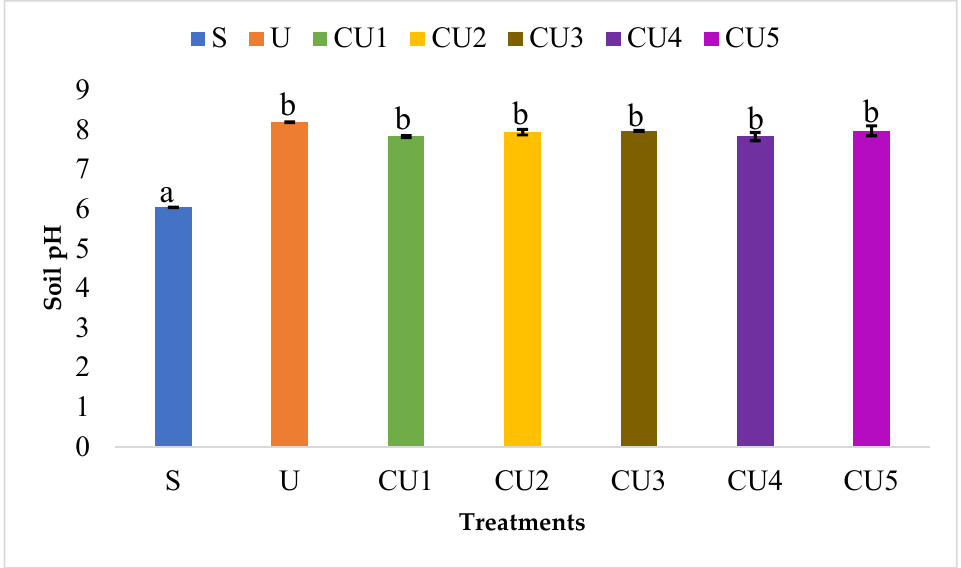
Figure 9. Soil pH of different treatments after ammonia volatilization. Note: Mean values with different letter(s) indicate significant differences between treatments using Duncan’s test at p ≤ 0.05. The error bars show the standard errors on the replicates in the means of each treatment. Urea coated with 2% RSS (CU1) showed higher retention of soil exchangeable NH 4+